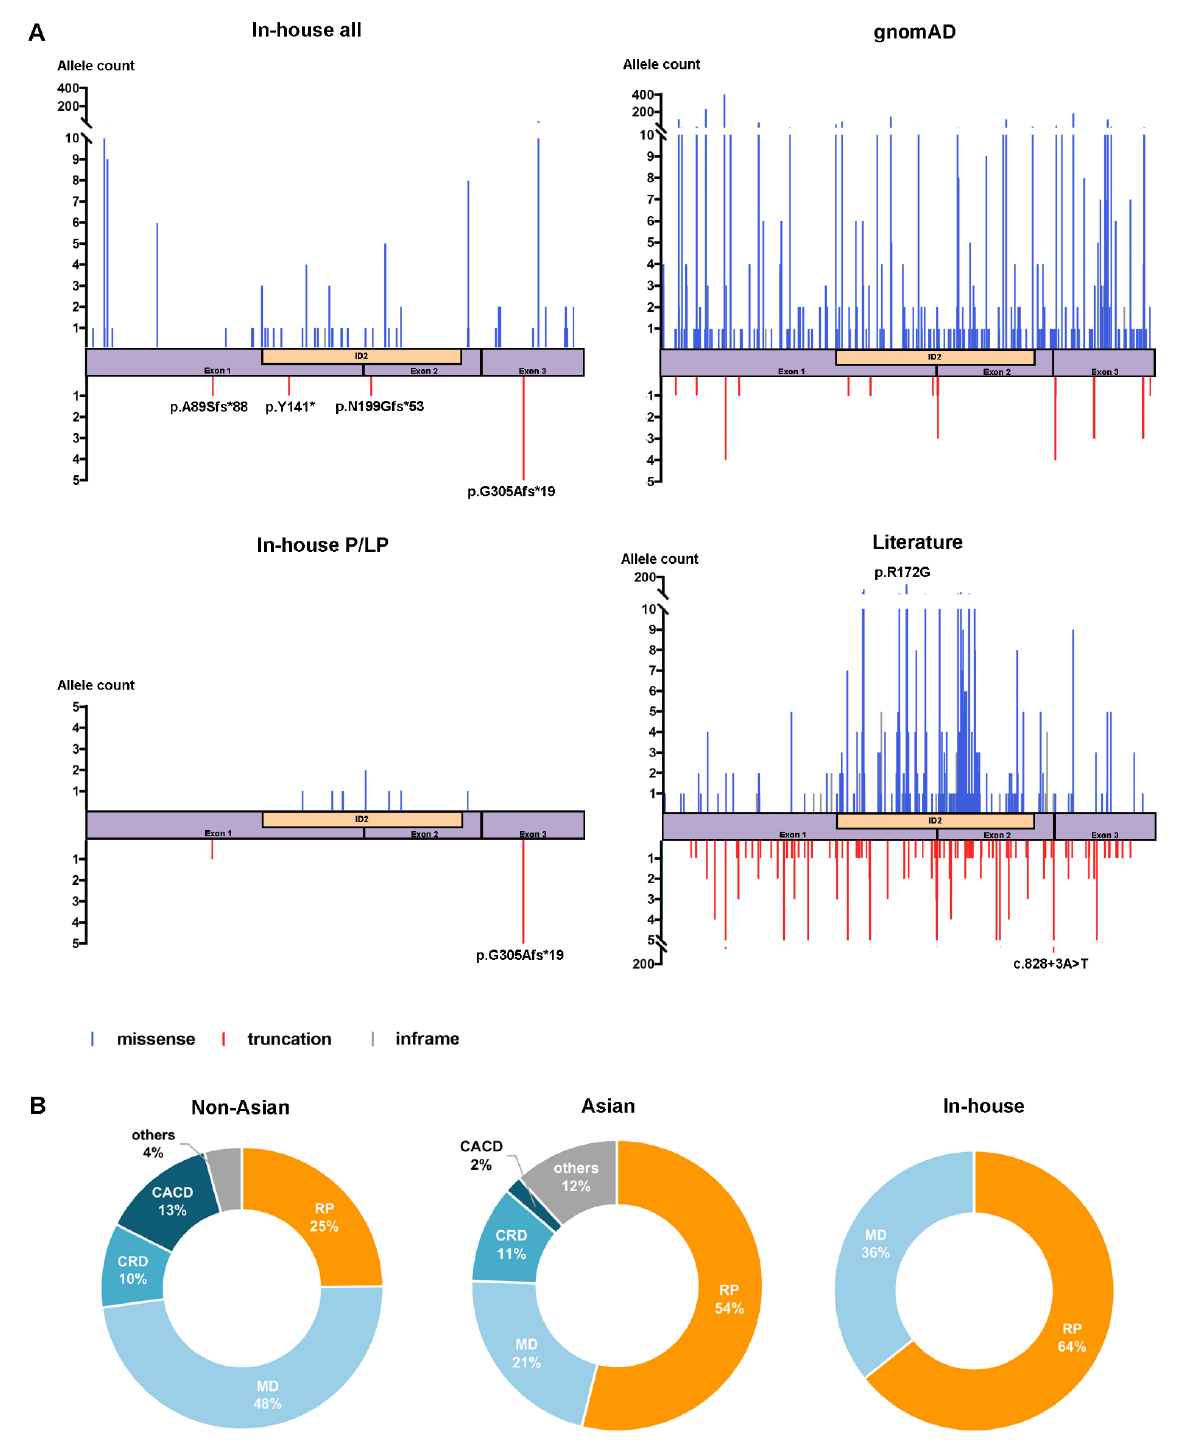
Figure 3. The genotypic and phenotypic spectrum of variants in PRPH2 in our cohort and reported in the literature. ( A ) Distribution and frequency of all detected PRPH2 variants in our cohort, the gnomAD database, pathogenic or likely pathogenic PRPH2 variants in our cohort, and reported PRPH2 variants in the literature. The blue, red, and gray lines represent missense, truncation, and in-frame variants, respectively. ID2 indicates the intradiscal D2 loop of the peripherin protein. ( B ) The three pie charts show the phenotypic spectrum of families with PRPH2 variants identified in our cohort, Asian families, and all reported non-Asian families with PRPH2 -associated retinopathy in the literature,